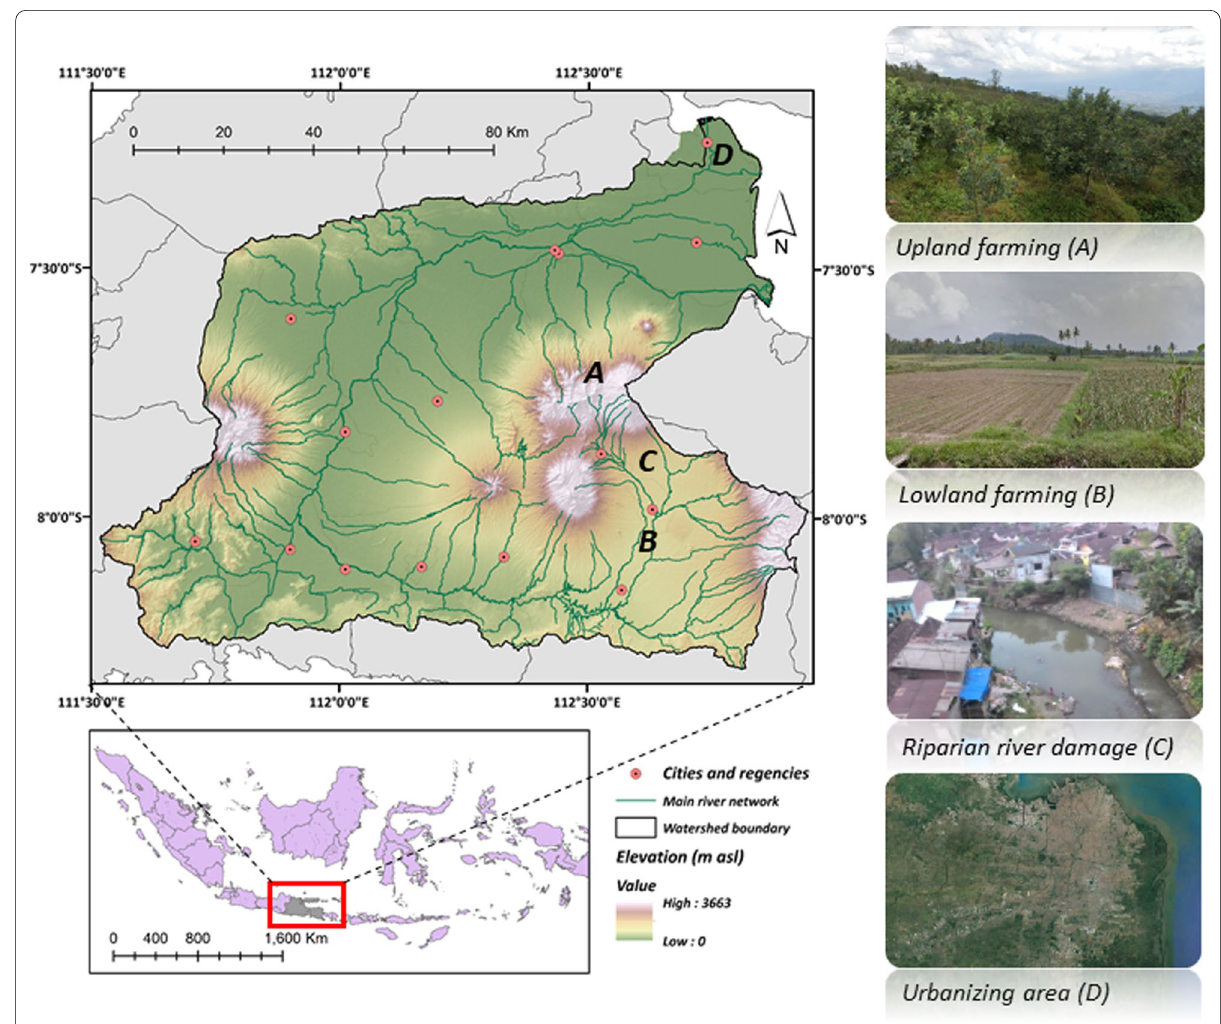
Fig. 1 Overview of the study area Brantas watershed with some backgrounds of the ground conditions (insert picture A , B , C and D